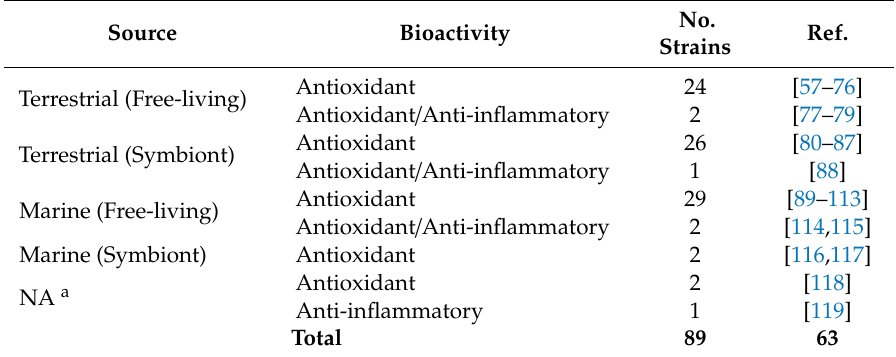
Table 1. Number of Streptomyces strains with crude extract screened for photoprotective-related activities.